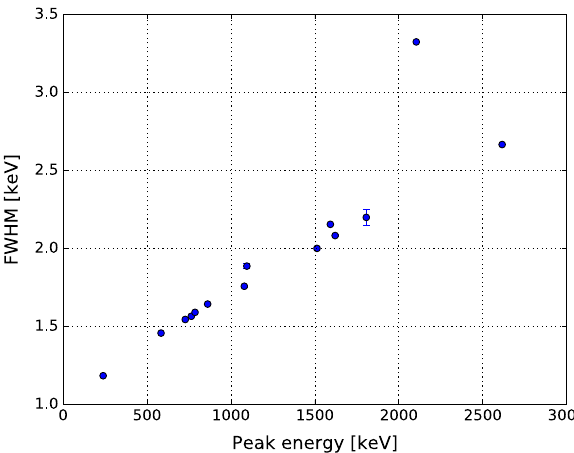
Fig. 2 Energy resolution of the peaks in the 228 Th spectrum. The out- lying peak at 2103 keV is a single escape peak from 2615 keV 208 Tl line.ItsabnormallyhighFWMHvalueisduetotheDopplerbroadening [12]